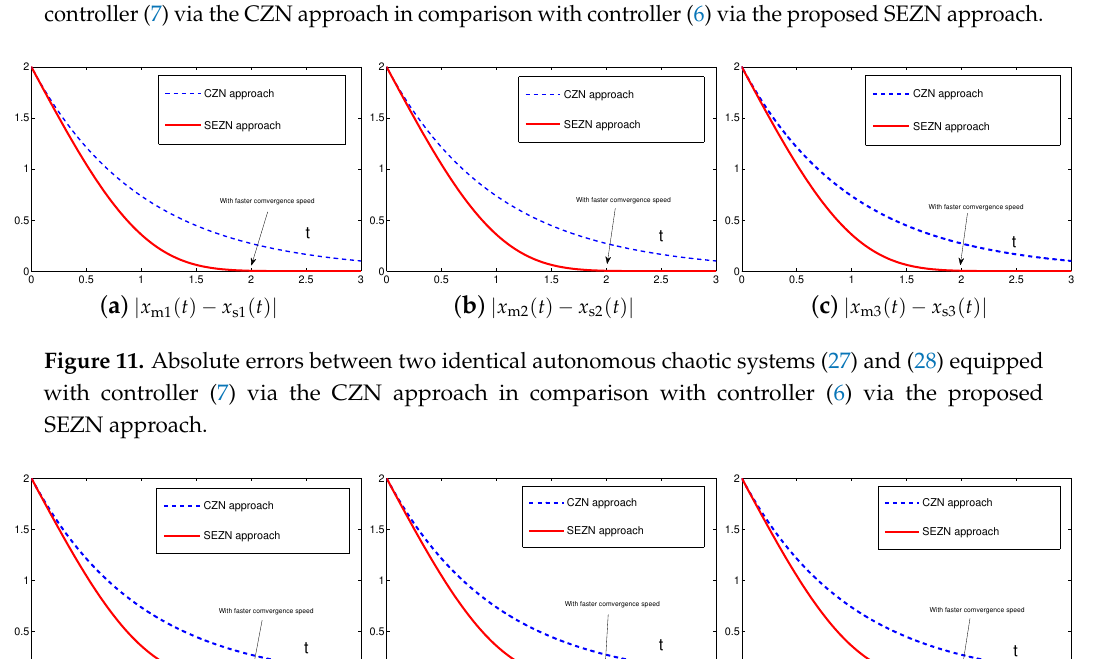
Figure 10. Absolute errors between two identical Lu chaotic systems (24) and (25) equipped with controller (7) via the CZN approach in comparison with controller (6) via the proposed SEZN approach.